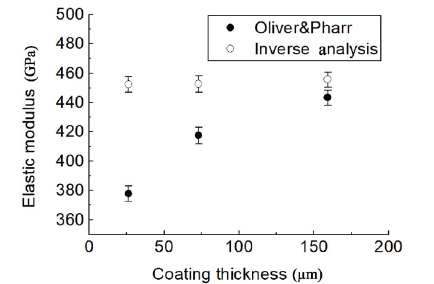
Fig. 12 Comparison of the modulus measured normal to the coating surface at different coating thicknesses using the analytic Oliver & Pharr method and the inverse analysis procedure.